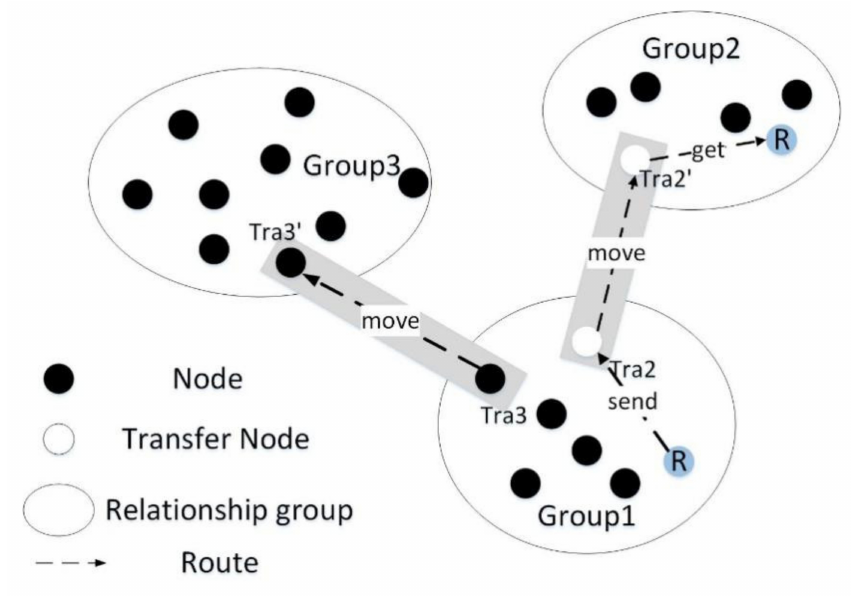
Figure 4. Query algorithm based on node movement